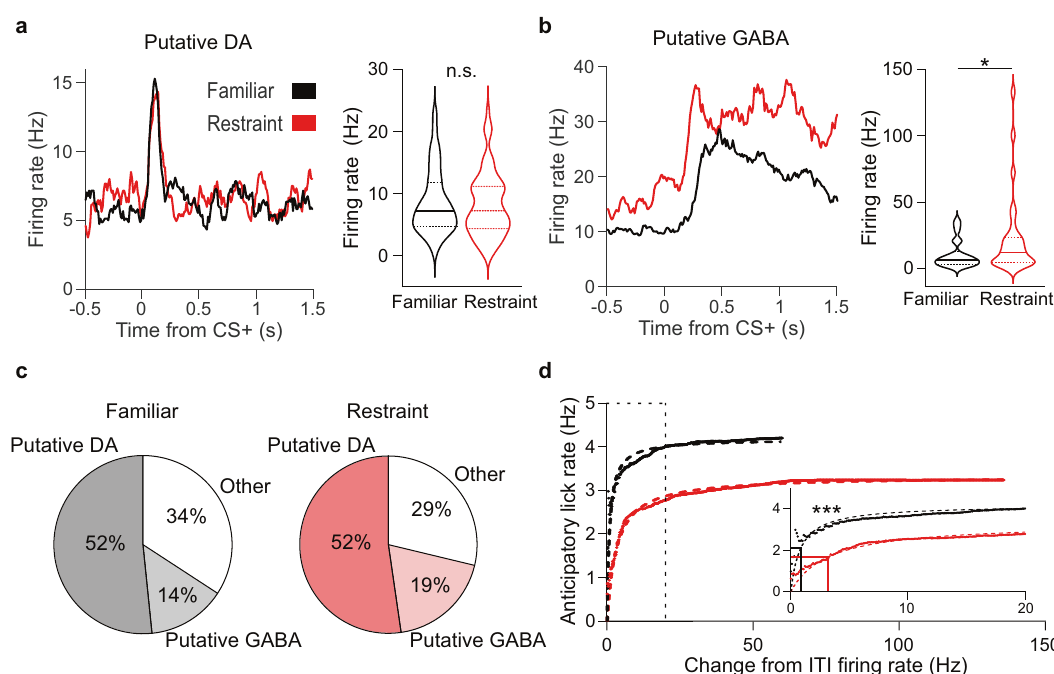
Fig. 7 Restraint enhances VTA GABA activity but weakens its relationship with anticipatory behavior. a Left: representative CS + evoked fi ring rates of putative DA neurons in non-stressed (black) and stressed (red) conditions. Right: CS + evoked fi ring rates for putative DA neurons recorded in non- stressed and stressed conditions. Restraint did not affect the CS + evoked fi ring rates of putative DA neurons ( P = 0.64, two-tailed rank-sum test, n Familiar = 80 neurons, n = 80 neurons). Data plotted are median, upper and lower quartiles, and kernel density estimate. b The same as a , but for putative Restraint GABA neurons. Restraint enhanced CS + evoked fi ring of putative GABA neurons (* P = 0.028, two-tailed rank-sum test, n Familiar = 22 neurons, n Restraint = 29 neurons). Data plotted are median, upper and lower quartiles, and kernel density estimate. c Distribution of putative DA and GABA neurons recorded during familiar environment and restraint stress conditions (total neurons n Familiar = 155, n Restraint = 153). d Relationship between cumulative change in fi ring rate of putative GABA neurons and average anticipatory lick rate for the familiar environment and restraint stress conditions. Dotted lines are nonlinear least-squares fi tted functions. Inset: Same data graphed up to 20 Hz. Solid lines indicate EC50 value calculated for the fi tted function. The EC50 value for the familiar environment fi tted function was smaller than that of the restraint stress fi tted function (*** P < 0.0001 two-tailed